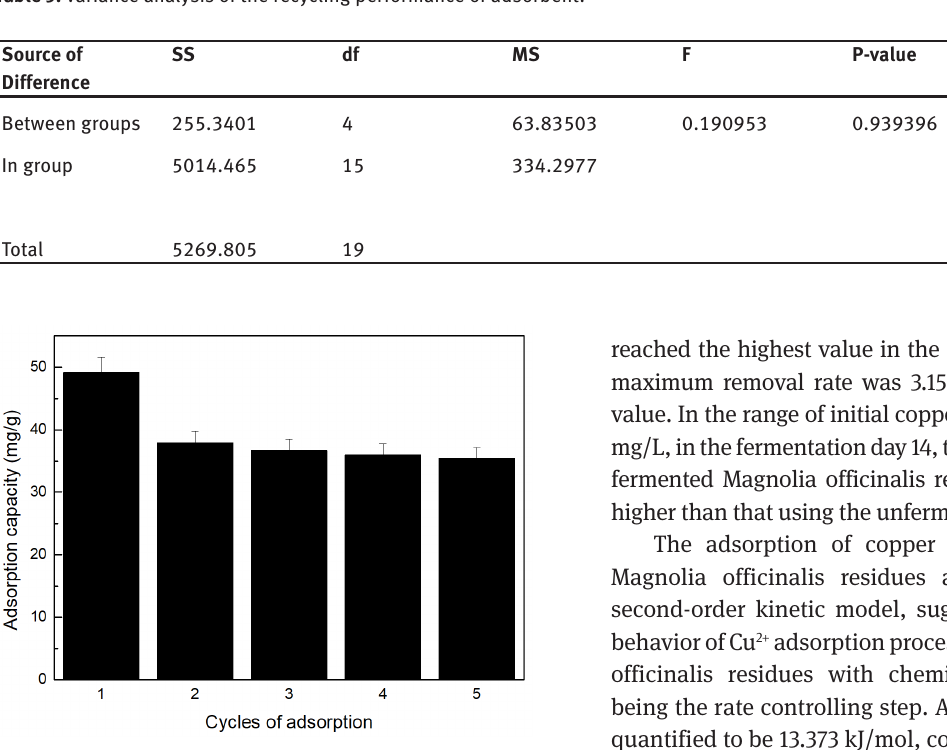
Table 5: variance analysis of the recycling performance of